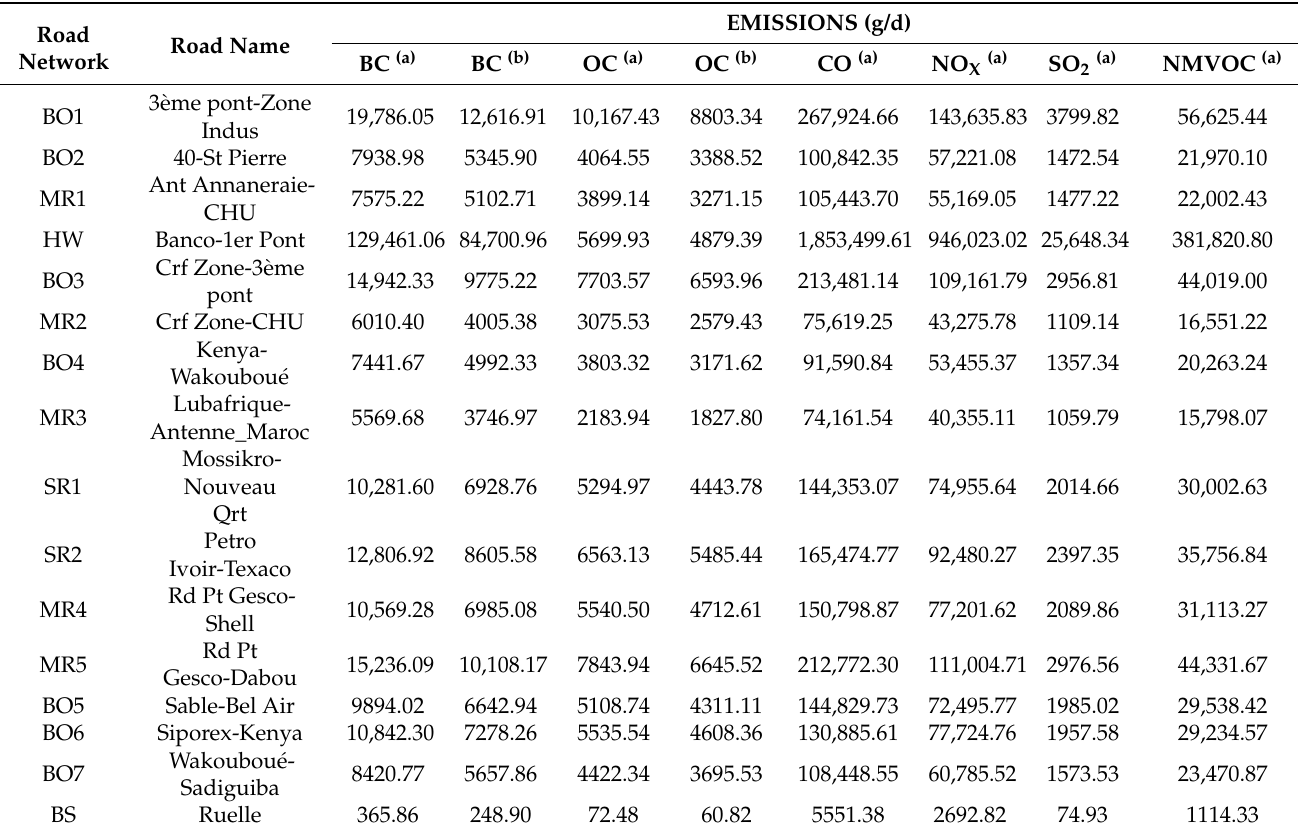
Table 2. Emissions of the different pollutants (g/d) on the different sampled axes of the city of Yopougon for road vehicles using emissions factors